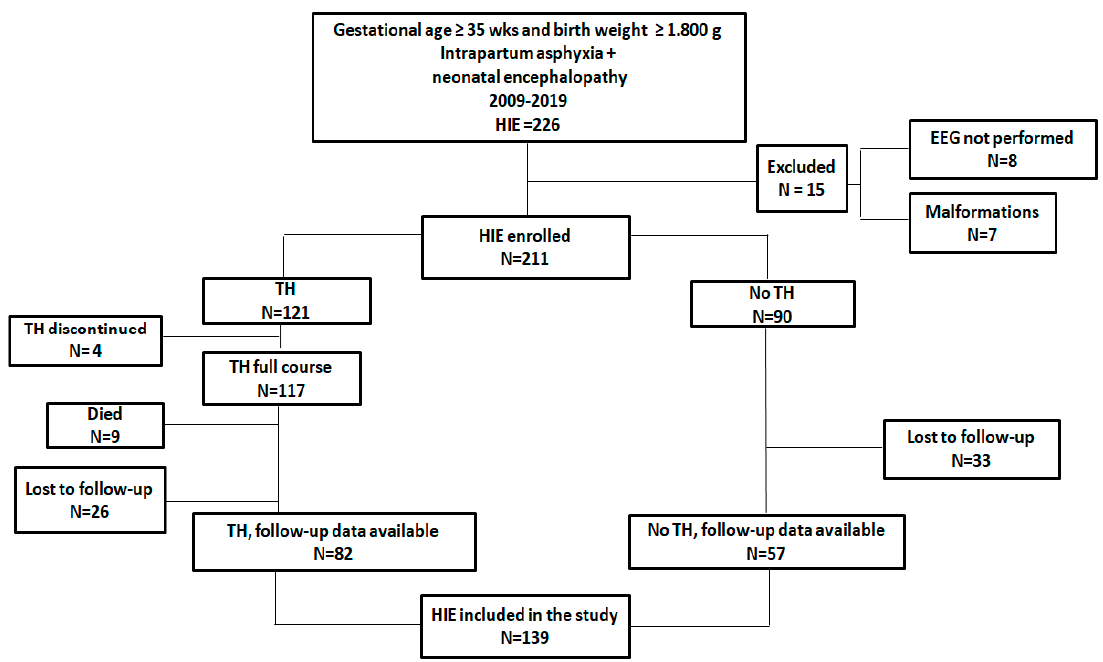
Figure 2. Flow_chart of asphyxiated infants undergoing or not undergoing therapeutic hypothermia. HIE: hypoxic–ischemic encephalopathy. TH: therapeutic hypothermia.